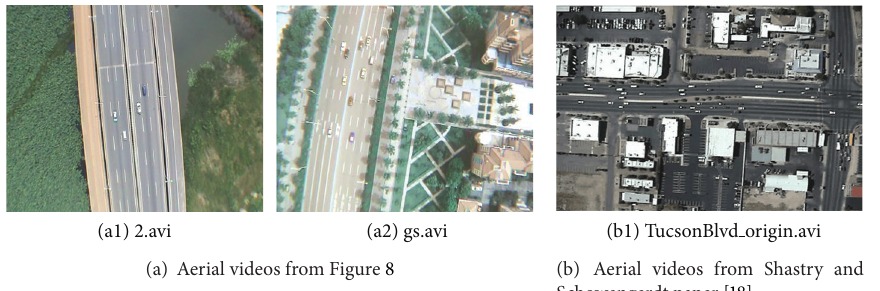
Figure 9: Snapshots of the experimental videos.